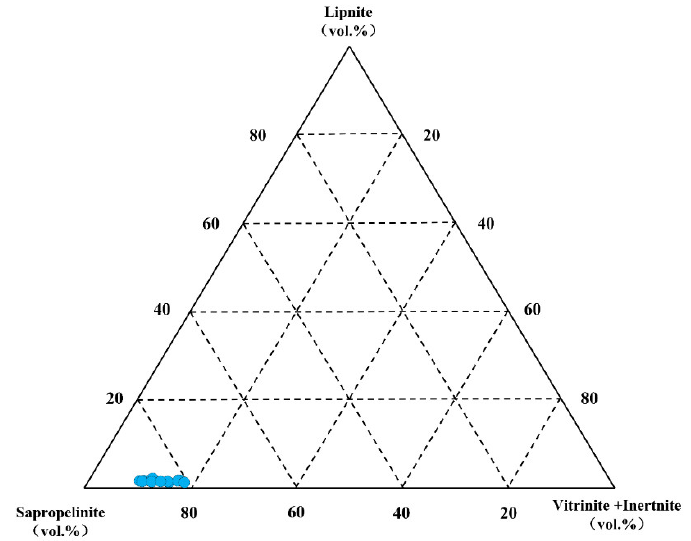
Figure 7. Ternary diagram of maceral composition for kerogen-type identification showing the dominance of sapropelinite and Type I and II 1 kerogen. Table 3. Composition of organic macerals of the Qingshankou lacustrine shales.